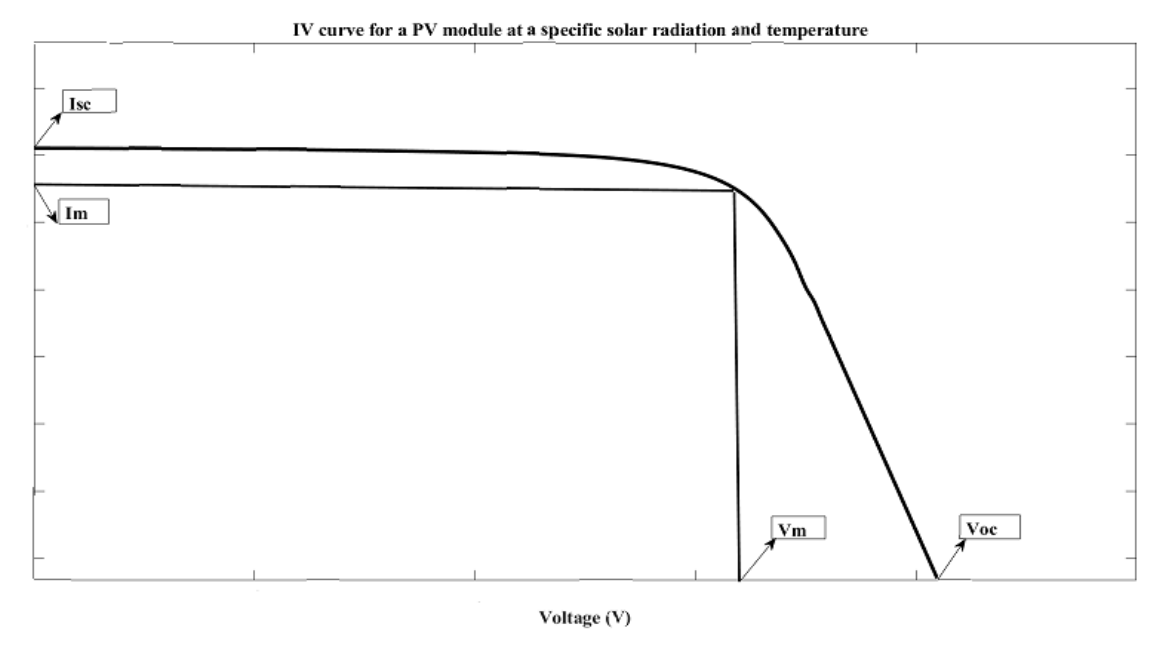
Figure 3. IV curve for a PV module.